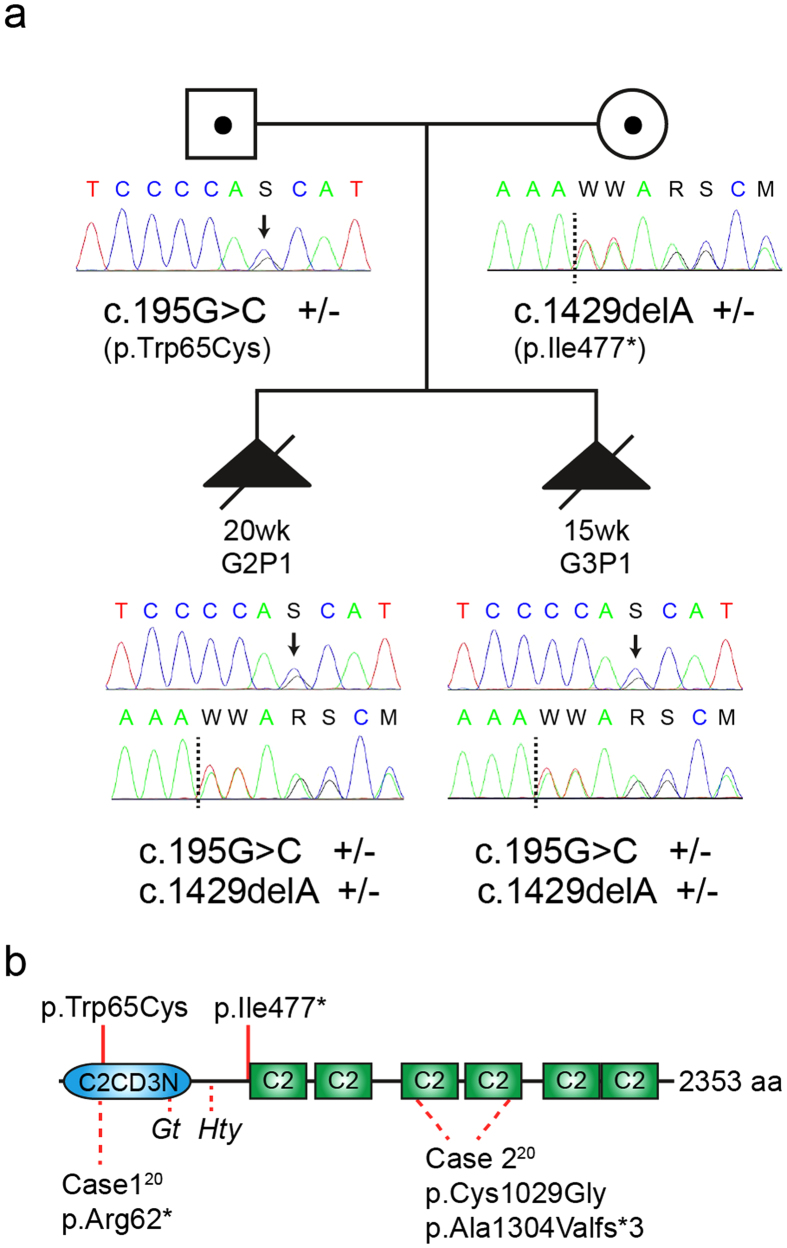
Segregation of C2CD3 mutations, and protein ideogram indicating location of variants.(a) C2CD3 variants present in the parents and affected individuals in the reported family. Sequence reads highlight genotype for variants identified by Sanger sequencing under each individual. Arrows denote missense mutation, dotted lines denote deletion site. Note that the sequence scan for the c.195G > C mutation shows the reverse strand sequence; the c.1429delA mutation is shown on the forward strand. (b) Human C2CD3 protein schematic showing mutations detected in the present study (red lines, top), mutations reported in previously reported OFDS cases20 (dotted lines, bottom) and mouse C2cd3 alleles C2Cd3Gt (Gt) and Hearty (Hty) (dotted lines, bottom). Note the C2cd3Gt mutation is predicted to result in a truncated protein encoding the N-terminal 161 amino acids only; aberrant splicing in Hty leads to proteins either truncated at amino acid 235, or with small in-frame deletions in the same region2021. C2: canonical C2 domains, C2CD3N: non-canonical globular C2 domain29.